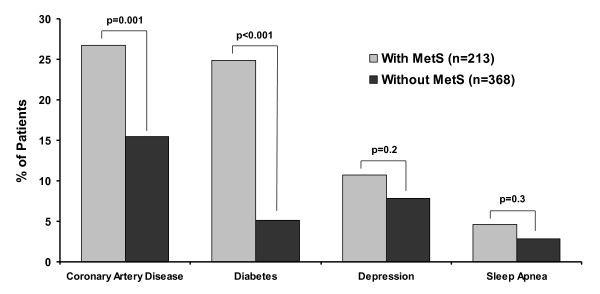
Percentage of patients with comorbid conditions at baseline, by MetS status. As expected, the percentage of patients with cardiovascular disease and diabetes was statistically higher in the MetS+ cohort (coronary artery disease [p = 0.001], and diabetes [p < 0.001]). Abbreviation: MetS = metabolic syndrome.